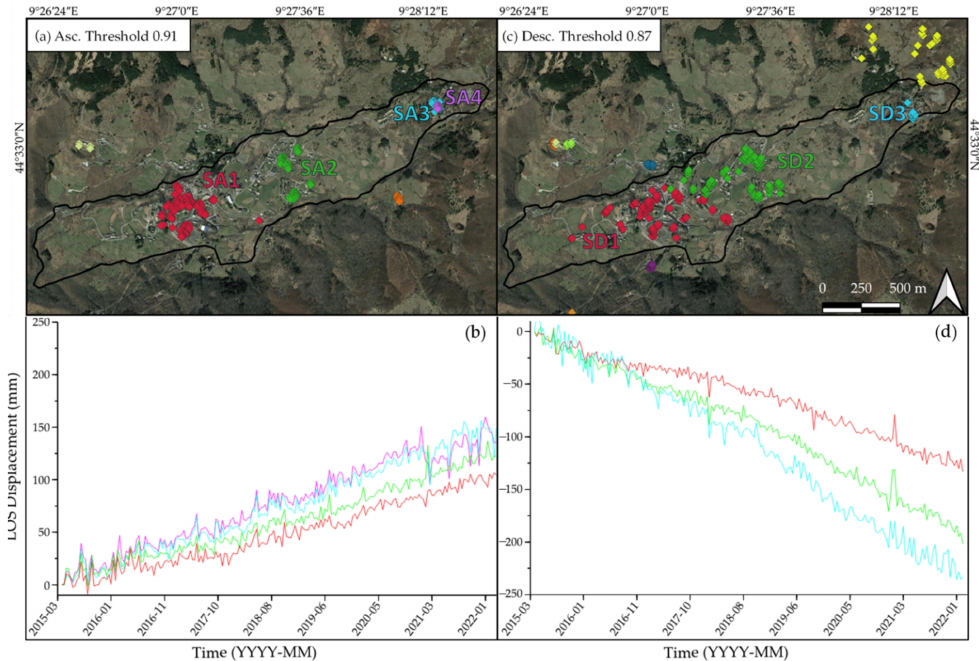
Figure 9. In ( a , c ) the chosen thresholds for ascending and descending orbit, respectively, are reported for the Santo Stefano d’Aveto test site. In ( b , d ) the time-series of a reference PS for each family identified with CAPS in both orbits are